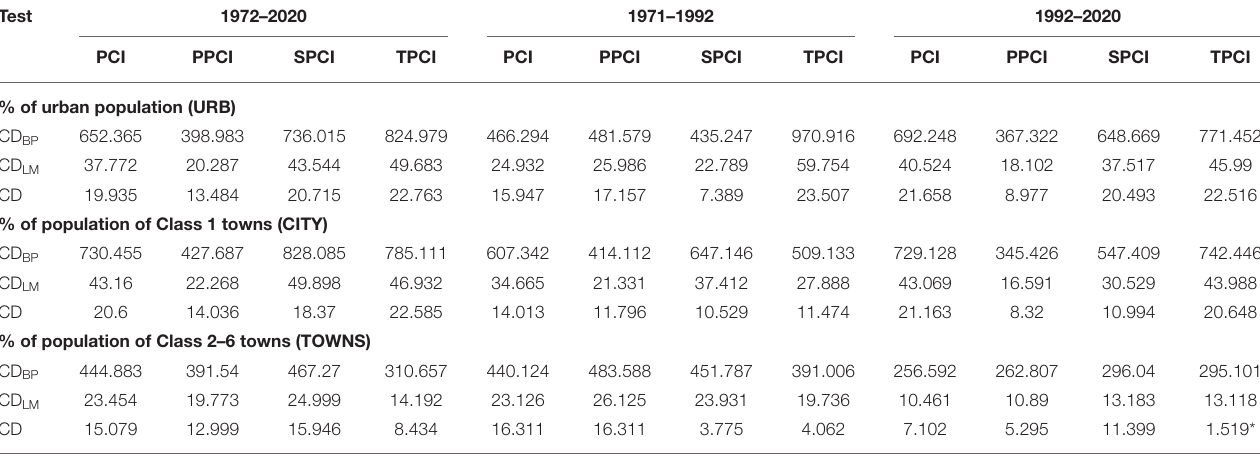
TABLE 1 | Cross-sectional dependence